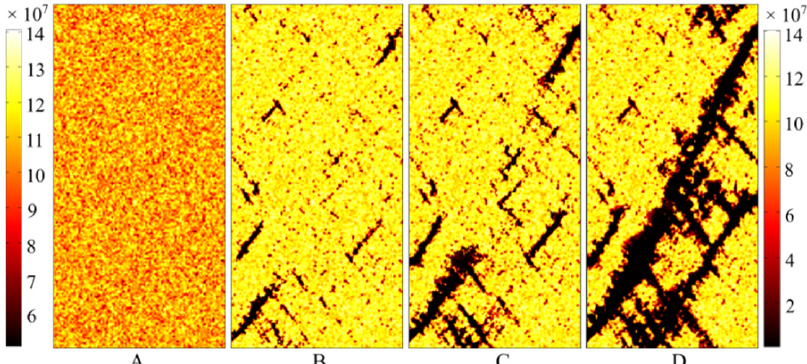
Figure 12. Strength failure snapshots extracted from the simulation result of the damage model. ( A ) An undamaged model. ( B ) Some cracks appear in the specimen. ( C ) Some cracks appear to accumulate and coalesce. ( D ) Main fracture surface is generated and some new cracks appear around the main fracture.